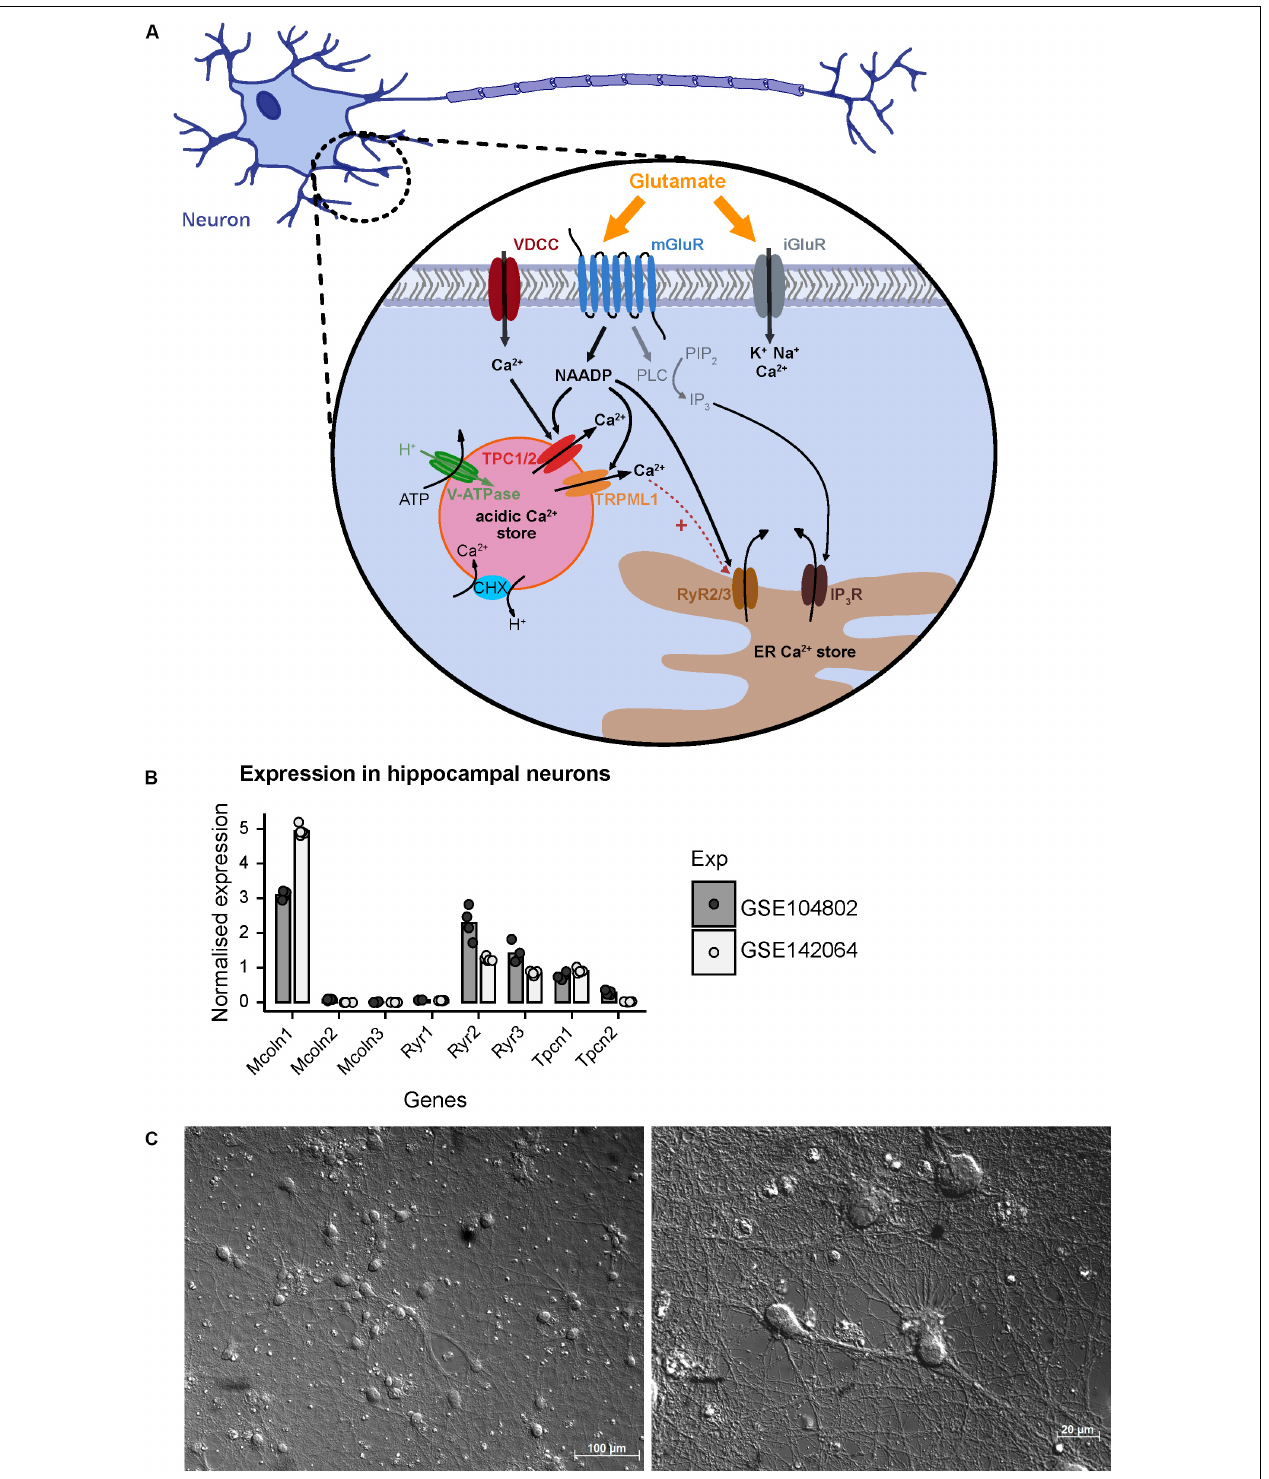
FIGURE 1 | A model based on current literature summarizing regulators of NAADP-mediated Ca 2 + homeostasis following extracellular glutamate action in hippocampal neurons of mice. (A) Glutamate activates ionotropic NMDA, AMPA, and KA receptors (iGluR) resulting in Ca 2 + influx across the plasma membrane. The activation of metabotropic glutamate receptors (mGluR) induces the synthesis of inositol trisphosphate (IP 3 ) which mediates Ca 2 + release from the endoplasmic reticulum (ER). In the CNS and particularly in hippocampal neurons glutamate induces the synthesis of nicotinic acid adenine dinucleotide phosphate (NAADP) and